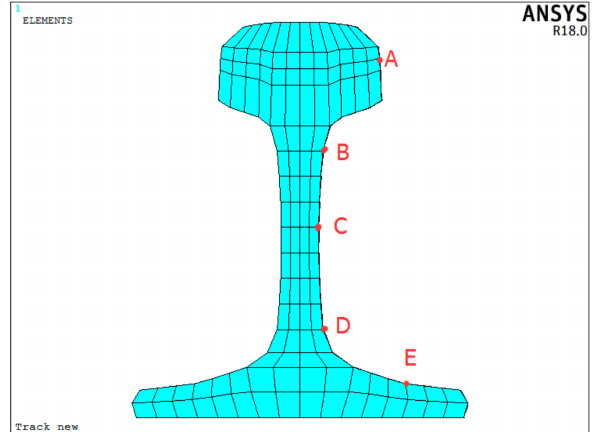
Figure 6. Selected positions on rail cross-section.